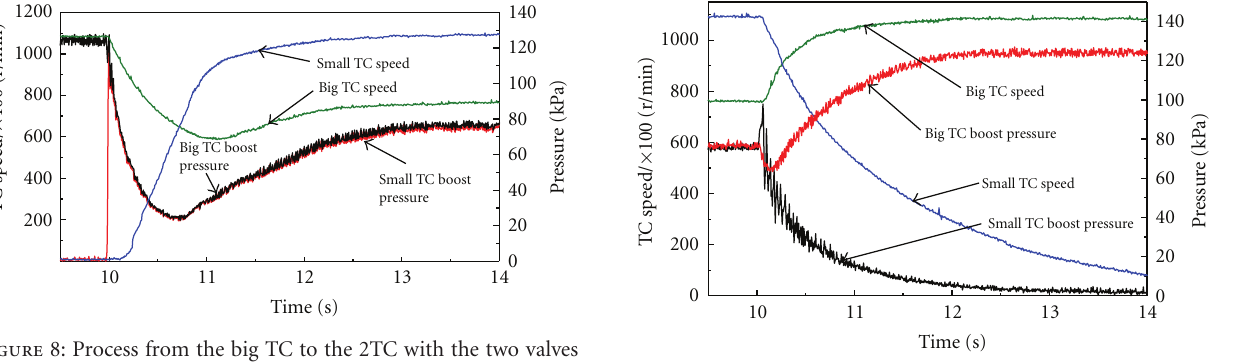
Figure 10: Process from the 2TC to the big TC with the two valves closed synchronously.